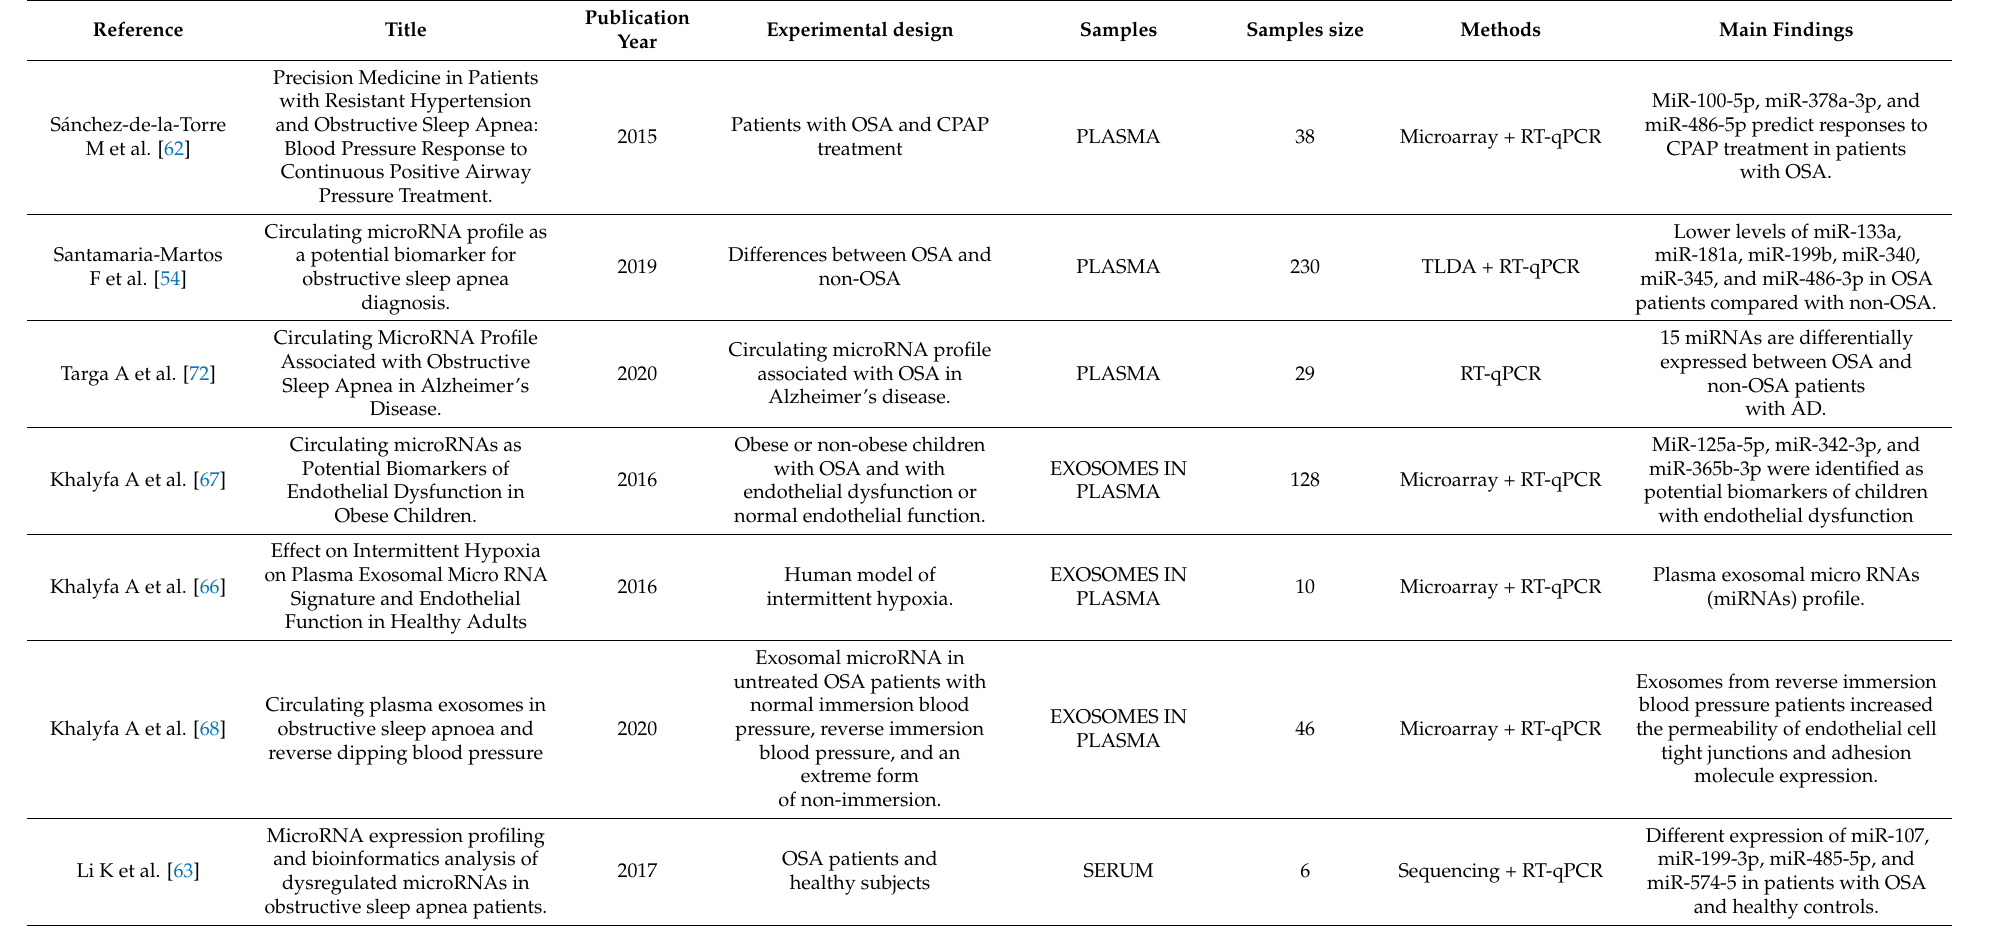
Table 2. Main studies on microRNAs in obstructive sleep